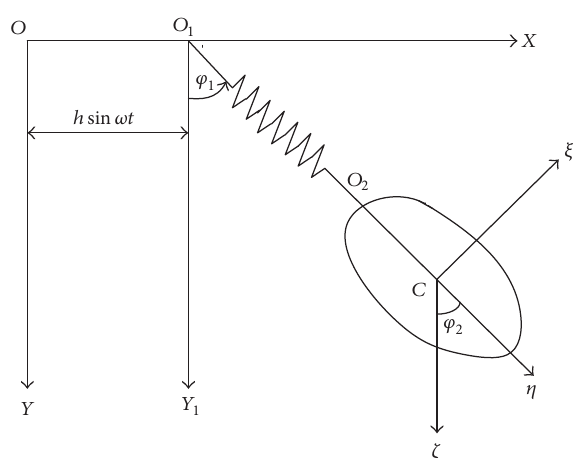
Figure 1: The rigid body pendulum. 𝑂𝑌 , relative to the motion of a rigid body of mass 𝑚 . The elastic spring is suspended to a point 𝑂 1 , where 𝑂𝑂 1 = ℎ sin 𝜔𝑡 at any time 𝑡 . Let us suppose that the rigid body is attached with the spring at the point 𝑂 2 and has the point 𝐶 as a center of mass, 𝜑 1 denotes the deformation angle between the spring and the vertical axis 𝑂 1 𝑌 1 , and 𝜑 2 refers to the angle between the straight line directed through 𝑂 2 to 𝐶 and the vertical. Choosing an orthogonal coordinates system 𝐶 , 𝐶𝜉 is 𝐶𝜉𝜂𝜁 of the body, in which 𝐶𝜂 directed along 𝑂 2 perpendicular to 𝐶𝜂 and lying in the 𝑂𝑋𝑌 plane, while 𝐶𝜁 is perpendicular to the 𝑂𝑋𝑌 plane (see Figure 1). Assume, the principal axes of inertia of the